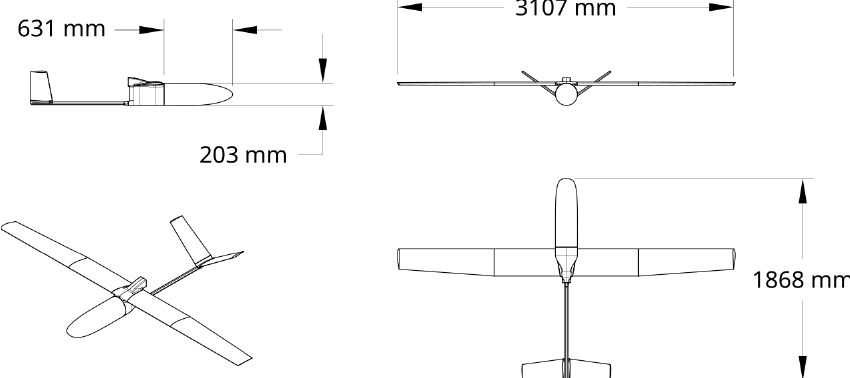
Figure 2. Overview of the S2 fixed-wing